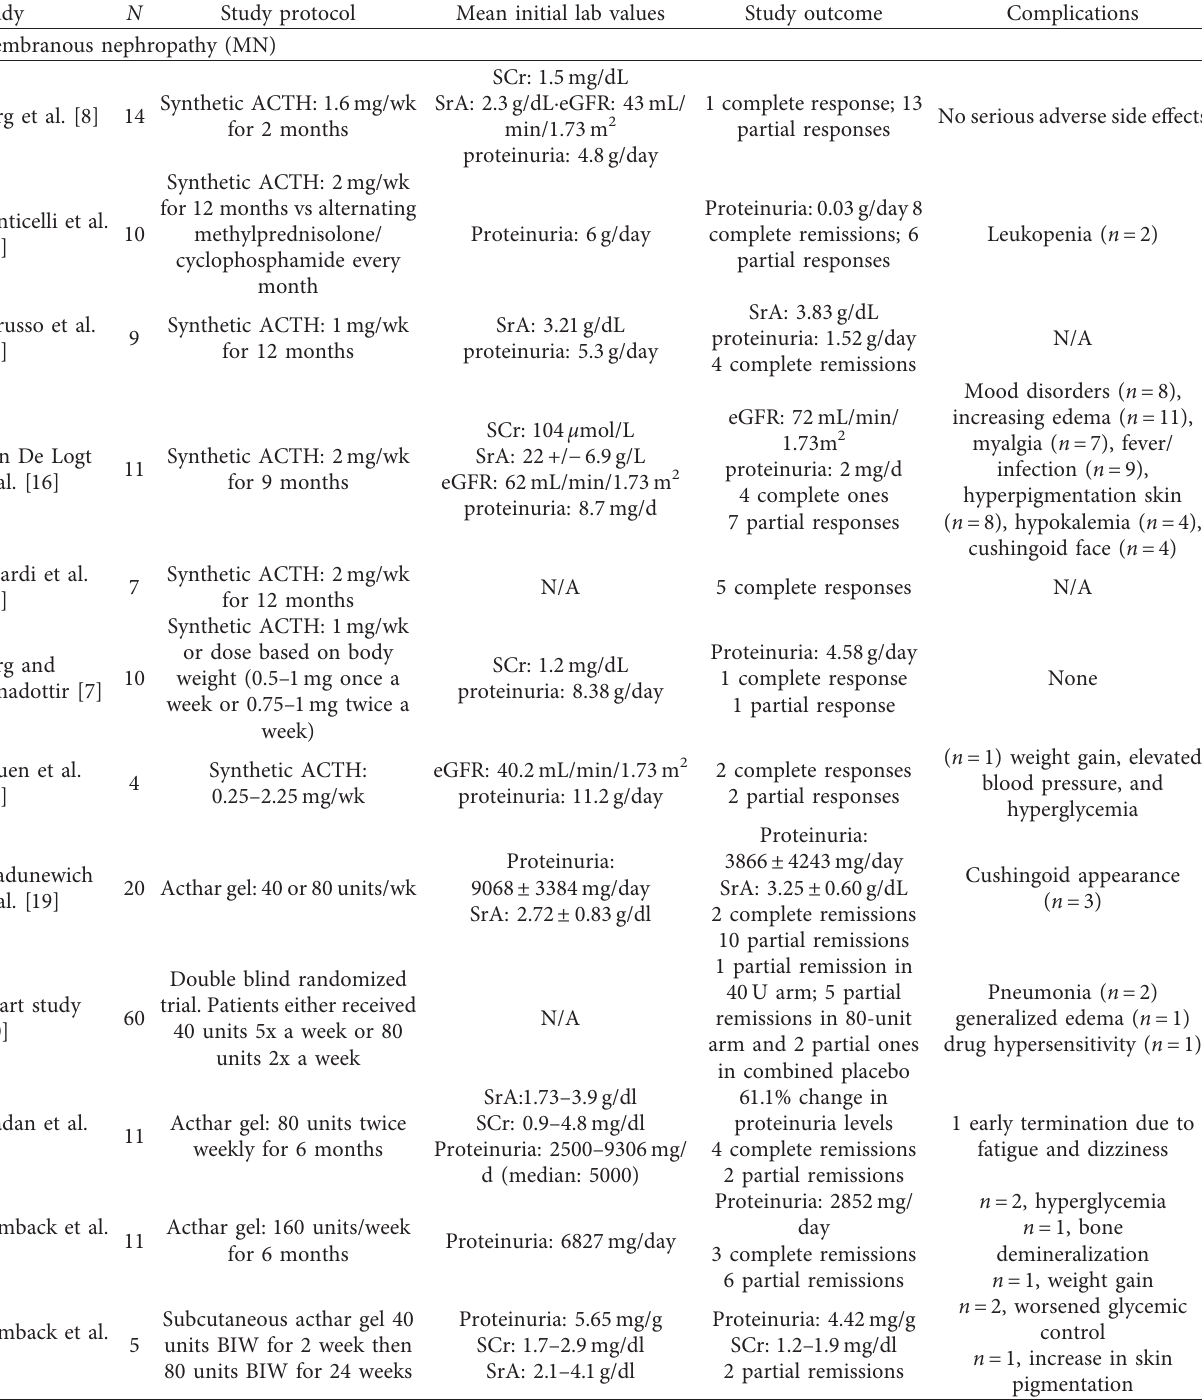
Table 5: Summary of studies on ACTH in membranous